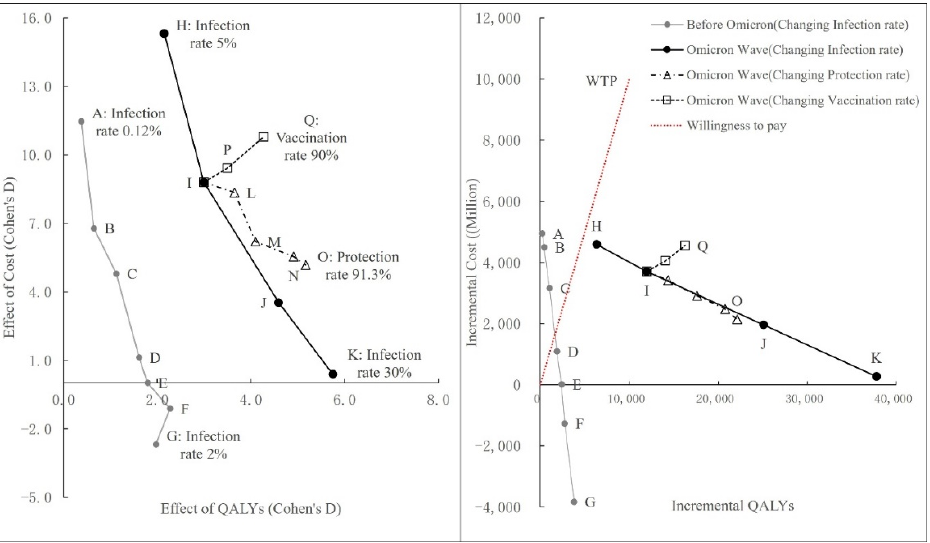
Figure 4. C–E plane of vaccination program of Hong Kong with scenarios in different infection rates, protection rates, and vaccination rates. (Point A–G show scenarios in different levels of the infection rate before Omicron wave. Point H–K show scenarios in different levels of the infection rate under Omicron wave. Point I, L–O show scenarios in different protection rate. Point I, P–Q shows scenarios in different vaccination